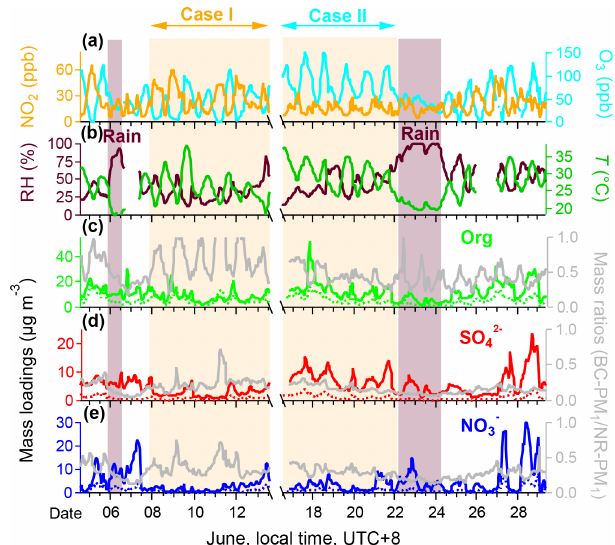
Figure 1. Temporal variations of selected chemical species mea- sured in Beijing on 4–29 June 2017. (a) Mixing ratios of nitrogen dioxide (NO 2 ) and ozone (O 3 ). (b) 15m relative humidity (RH) and temperature ( T ). (c–e) On the left are the mass loadings of or- ganic (Org), sulfate (SO 2 − ) and nitrate (NO − ) measured by HR- 4 3 AMS and SP-AMS, and on the right are the mass ratios of indi- vidual BC − PM 1 species to NR − PM 1 species (e.g., BC − PM 1 Org to NR − PM 1 Org). The NR − PM 1 species measured by HR-AMS is shown by the solid line, and the BC − PM 1 species measured by SP-AMS is shown by the dotted line. The shaded areas are raining periods. The observation period is divided into two cases accord- ing to the mixing ratio of nitrogen NO 2 , Case I and Case II, which represent high NO 2 and low NO 2 mixing ratios,